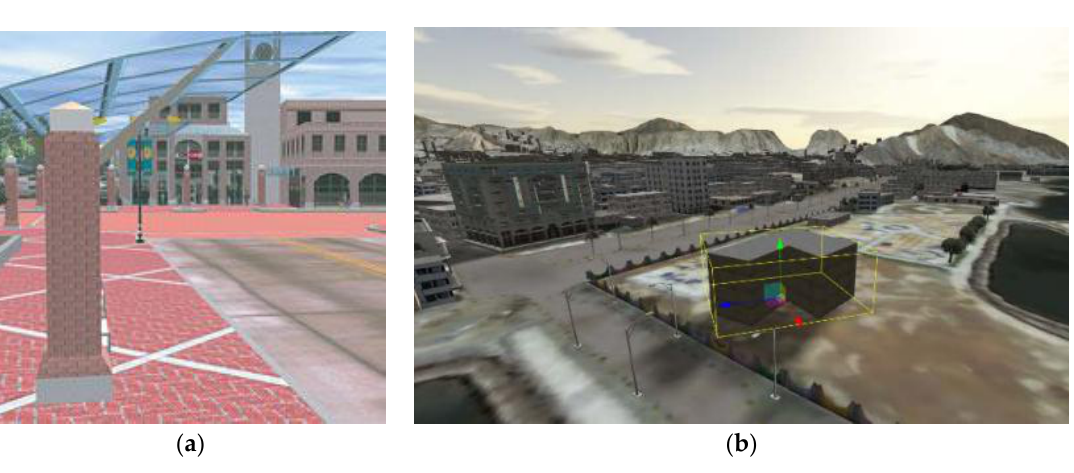
Figure 1. Two use cases for the Common DataBase’s (CDB’s) structured representation in real-time: ( a ) Sunnyvale city planning [21] and ( b ) Joint staff training [22].